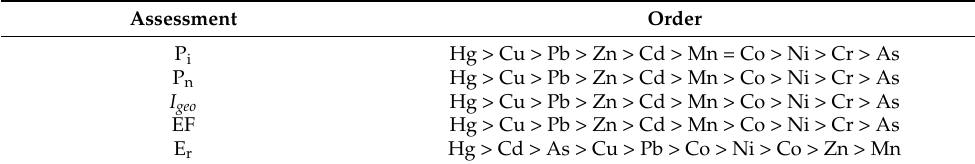
Table 10. Decreasing order of heavy metal